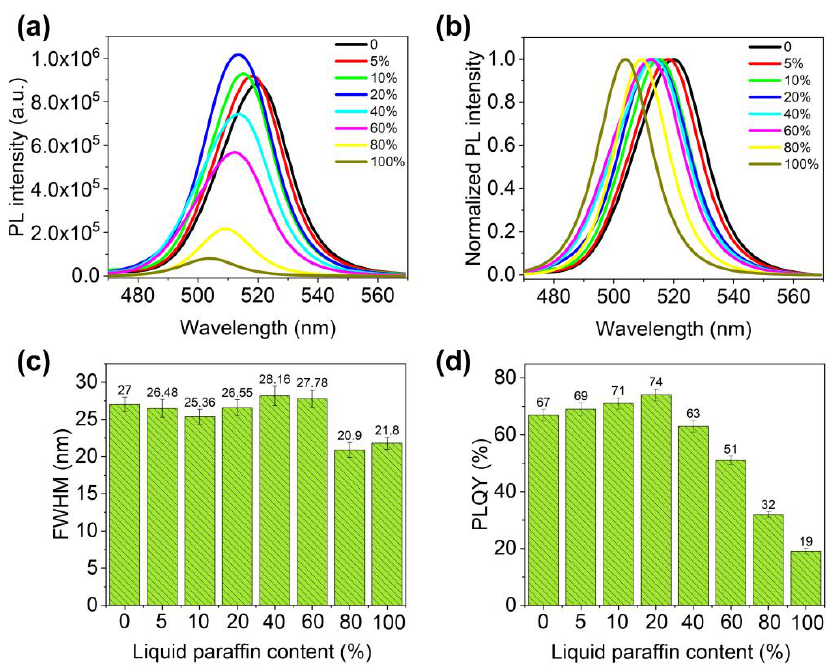
Figure 6. Optical properties of the CsPbBr 3 /Cs 4 PbBr 6 synthesized by different liquid paraffin contents (0–100%): ( a ) PL emission spectra; ( b ) normalized PL emission spectra; ( c ) FWHM; ( d ) PLQY.